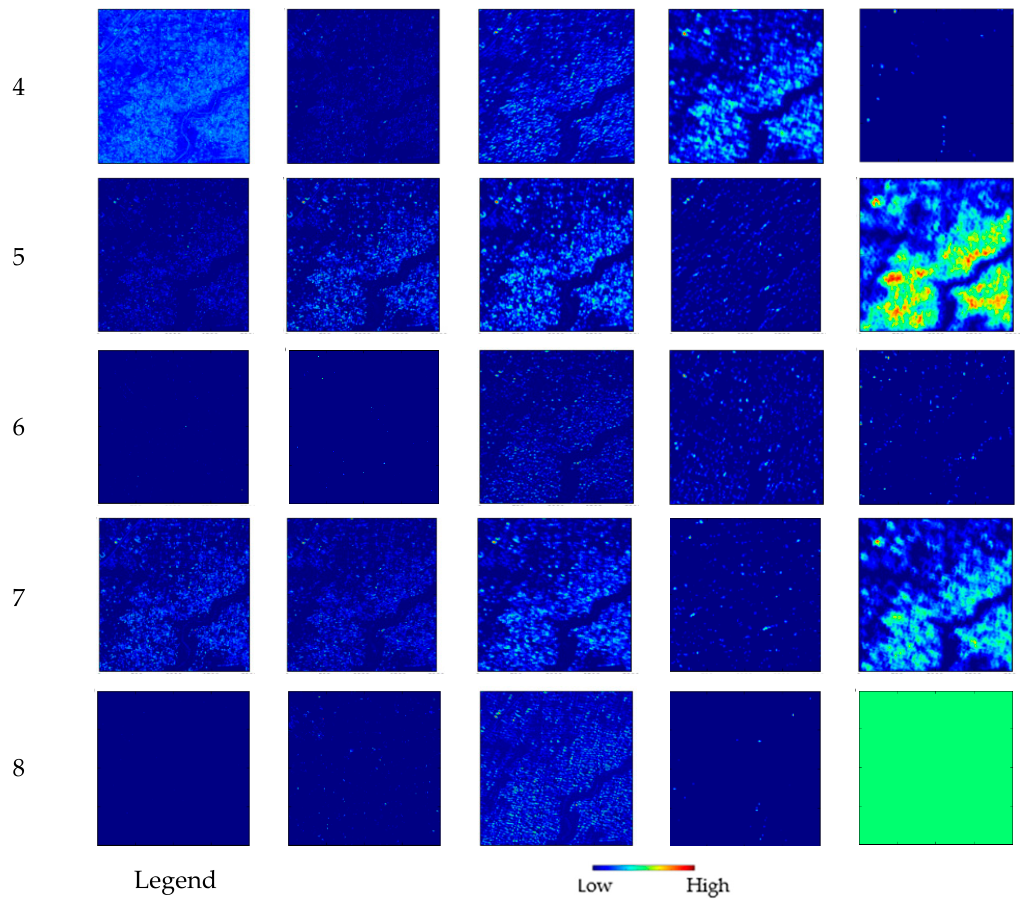
Figure 9. An illustration of eight feature maps for tile 1, derived from a CNN with five layers for each of the layers. The feature maps are upsampled through bilinear interpolation to attain a resolution of 2000 × 2000 pixels for visualization. High values are obtained where there is a strong response in the activations as the filter convolves over the input image.